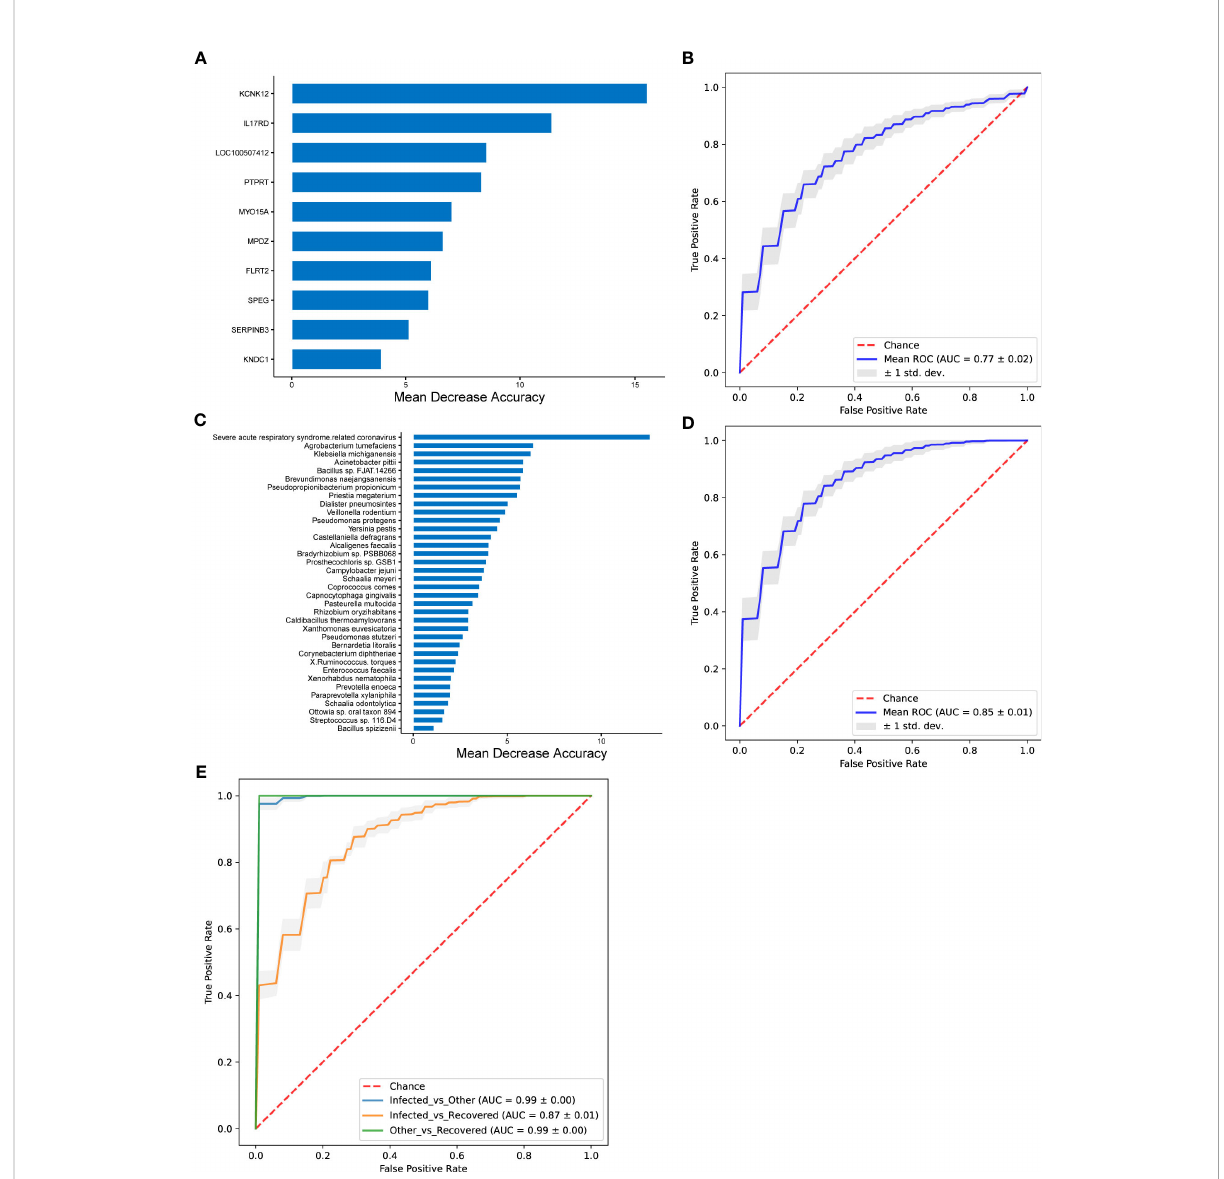
FIGURE 6 The performance of random forest classi fi er and associated important features. (A, B) Performance of random forest model with differential genes for infected vs. recovered groups. (C, D) Performance of random forest model with differential microbial taxa for infected vs. recovered groups. (E) Performance of random forest model with both differential genes and differential microbial taxa. The important features were selected using MDA (mean decrease in accuracy) algorithm (A, C) , and mean ROC curves are shown with ± 1 standard deviation in gray shading (B, D) . AUC, area under the curve; ROC, receiver operating characteristic; std. dev., standard